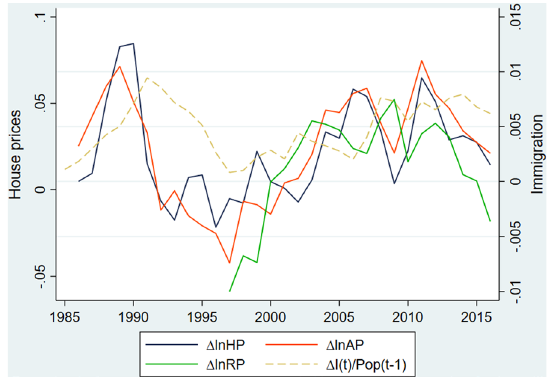
Fig. 3 Growth rate of housing price indices and immigration